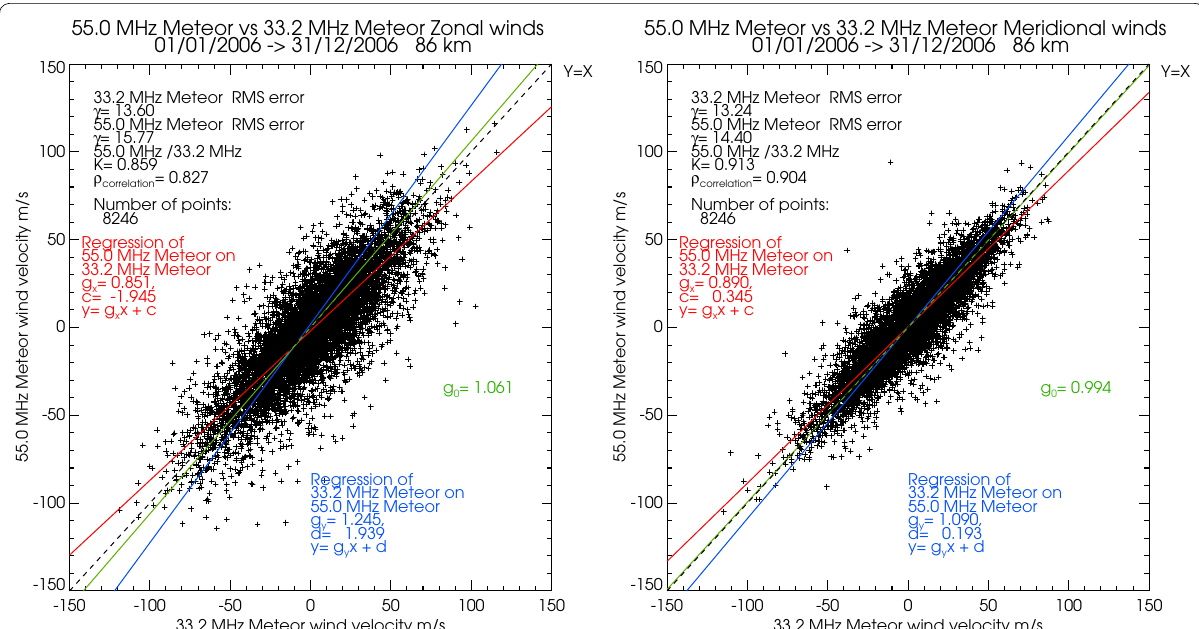
Fig. 3 Representative examples of scatter plots of hourly averaged zonal (left) and meridional (right) winds for a height of 86 km for 2006. The red line is the slope to the linear fit when performing the regression of the 55 MHz data on the 33.2 MHz data. In this case, it is assumed that the 33.2 MHz velocity data set contains no errors and that all errors can be attributed to the 55 MHz data set. The blue line is the result when assuming that the 33.2 MHz data contain all of the error. These lines form a bounding region in which the true slope of the line lays. The green line is the slope of the fit obtained using a total least squares regression. In this case, the meridional green line slope differs from 1.0 by differs